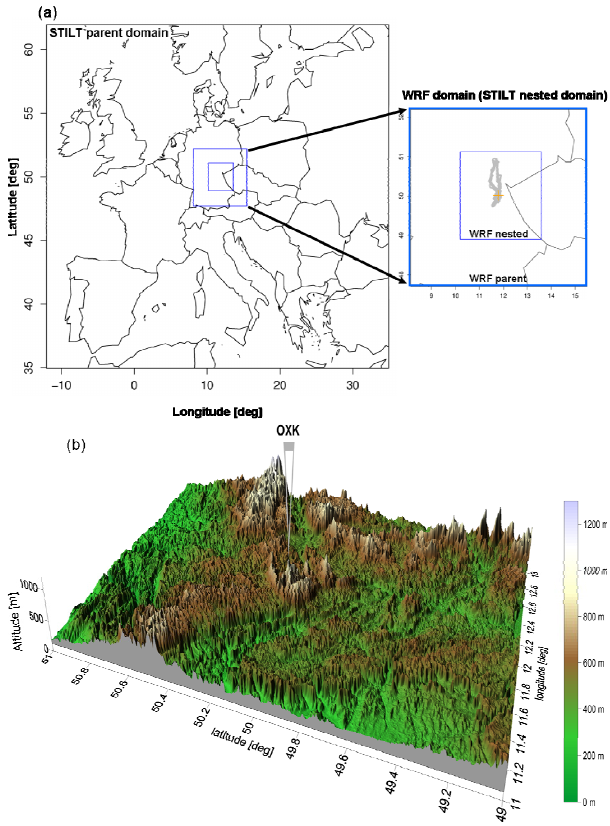
Fig. 1. (a) Map showing model domains used for WRF and STILT. Figure 1. (a) Map showing model domains used for WRF and STILT. STILT uses the STILT uses the larger domain covering Europe with two nests in- larger domain covering Europe with two nests indicated by the blue rectangles. These dicated by the blue rectangles. These two rectangles in blue repre- two rectangles in blue represent the WRF domains, which are centered over OXK (50 0 sent the WRF domains, which are centered over OXK (50 ◦ 01”N, 01" N, 11 0 48" E, marked with “+”). A zoom of the WRF domain is showed in right-hand 11 ◦ 48”E, marked with “+”). A zoom of the WRF domain is showed side of the main figure with an example of a DIMO flight track overlaid in grey lines. (b) in right-hand side of the main figure with an example of a DIMO Topography around OXK (the color gradient shows terrain height above sea-level). flight track overlaid in grey lines. (b) Topography around OXK (the color gradient shows terrain height